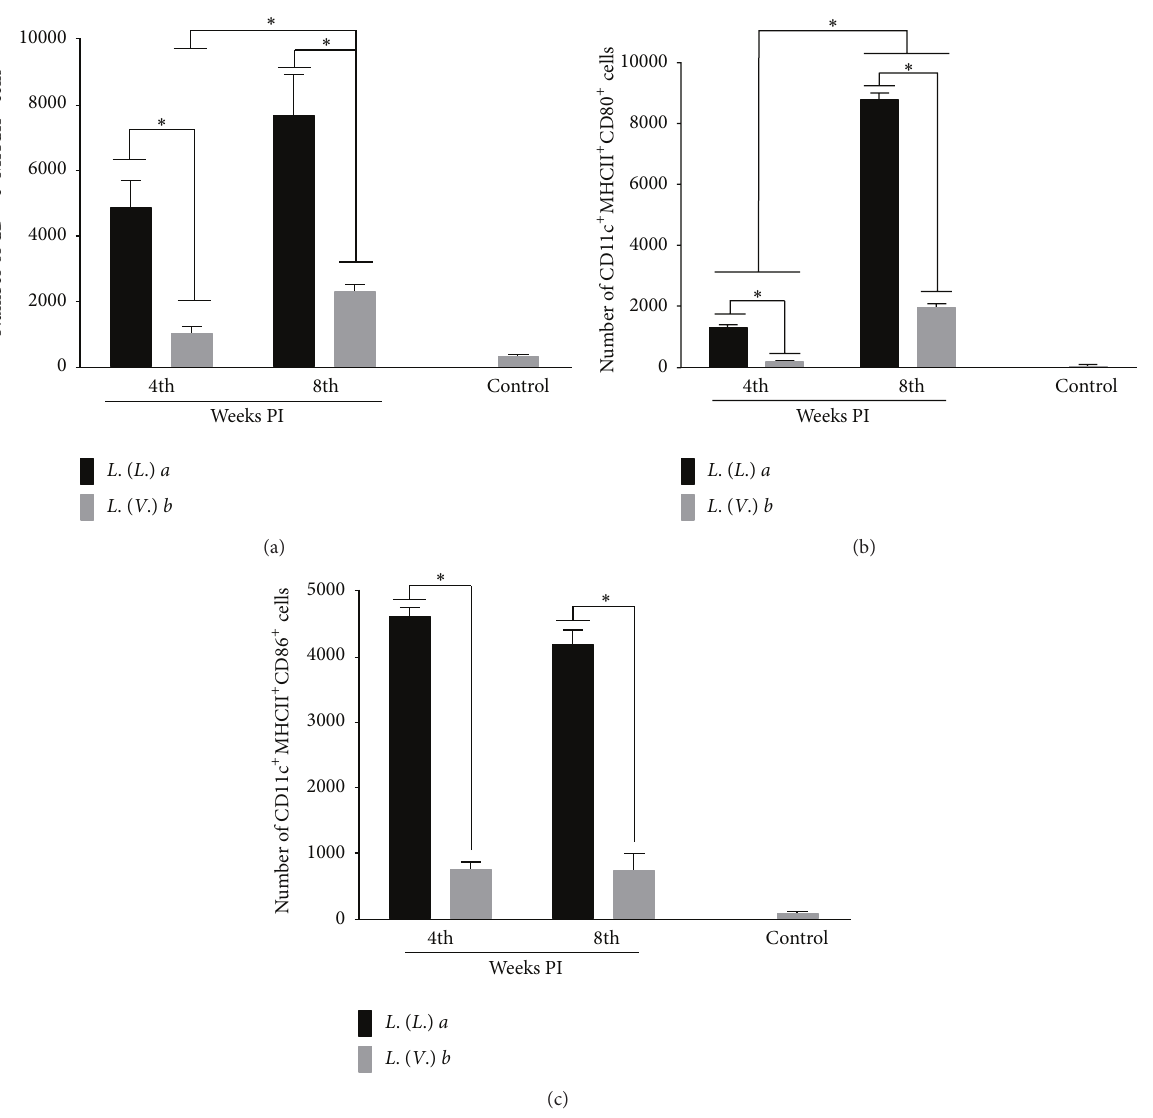
Figure 2: Phenotyping dendritic cells (DCs) from the popliteal lymph nodes of BALB/c mice infected with L. (L.) amazonensis or L. (V.) braziliensis and their activation. (a) DCs were stained for the surface expression of CD11c and MHC class II molecules, (b) and their status of activation was analyzed using CD80 (b) and CD86 (c) markers. Data represent the mean ± SD of three independent experiments. ∗ 𝑝 < 0.05